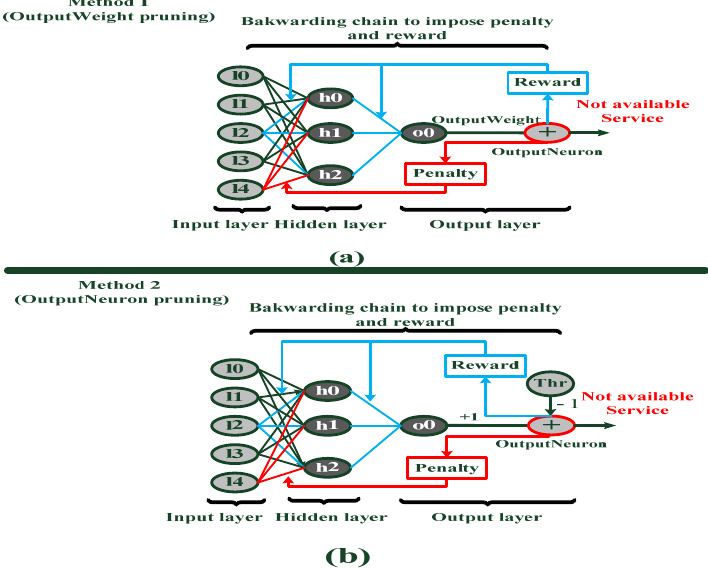
Figure 8. Backwarding chain to trust creation: ( a ) Imposing penalty and reward to output and hidden layer’s weight and trust creation considering method 1; ( b ) Imposing penalty and reward to output and hidden layer’s weight and trust creation considering method 2.